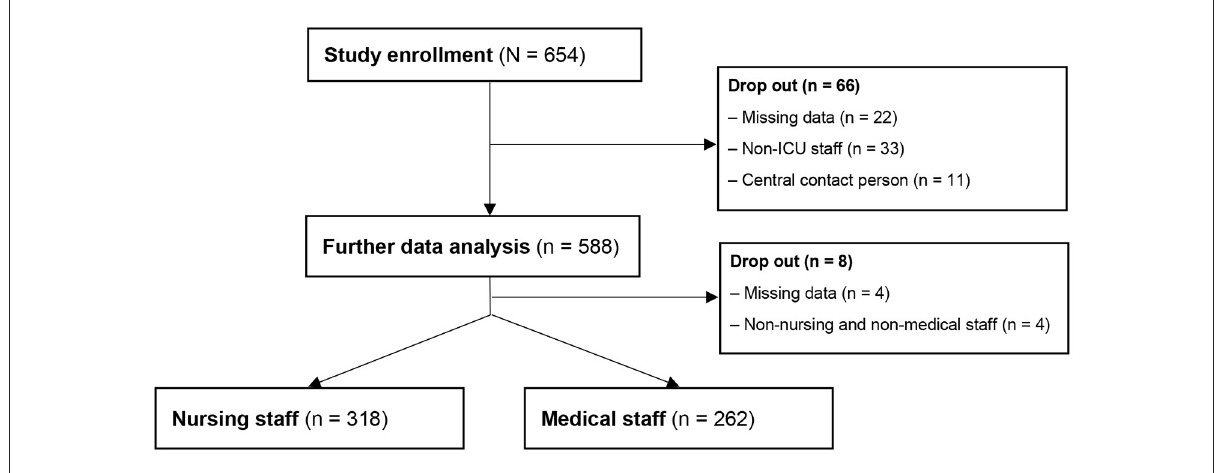
FIGURE2 Flow chart.